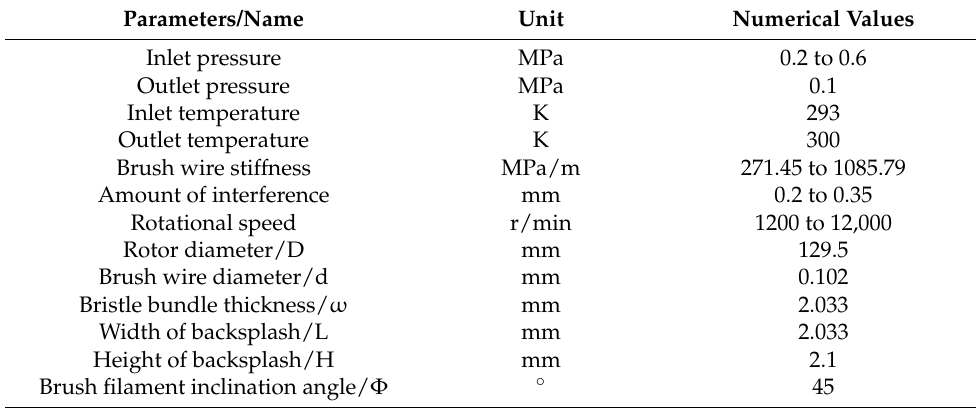
Table 2. Brush seal working parameters and geometric parameters.